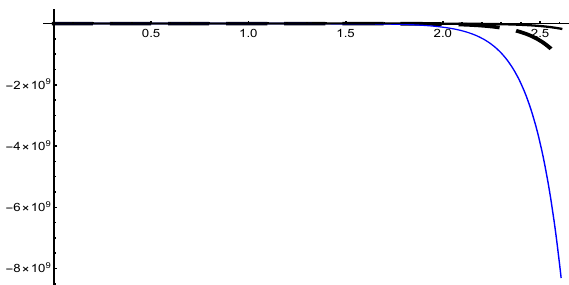
Figure 3. Graph of the function and its first and second derivatives. The black line shows the function, the dashed line shows the first derivative, and the blue line shows the second derivative.